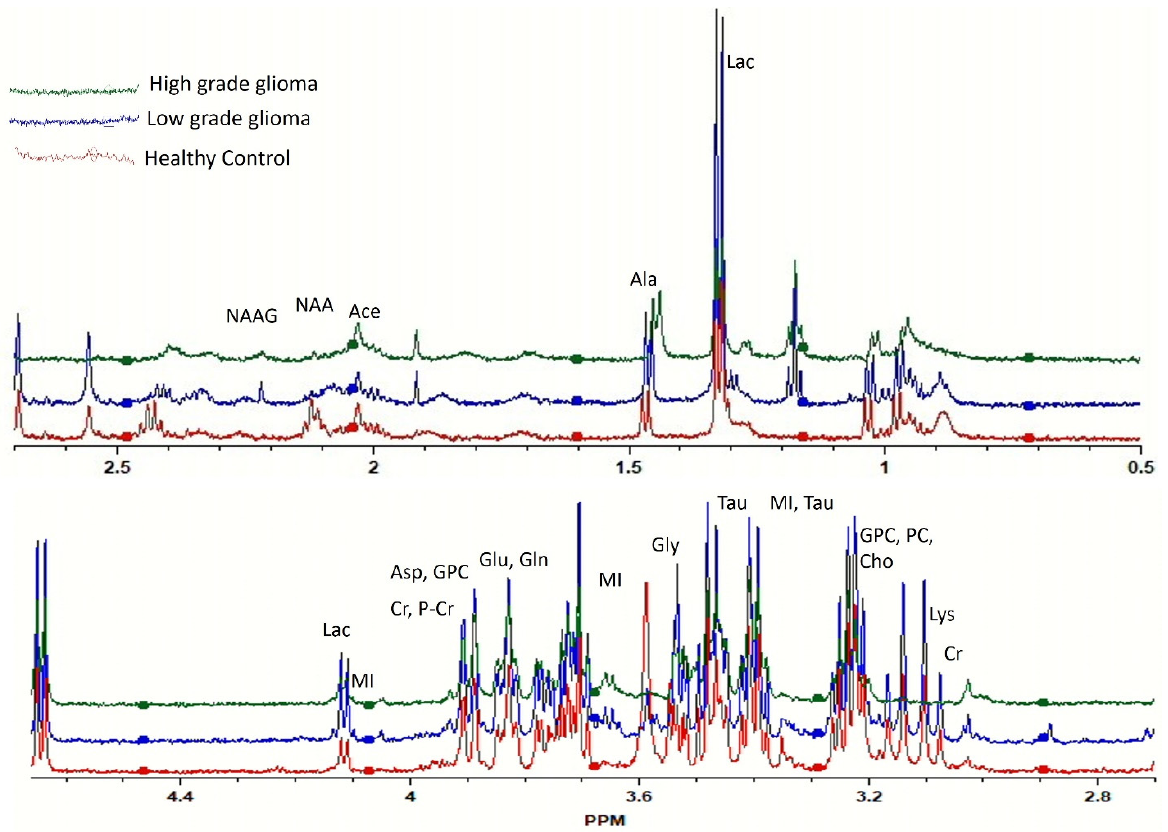
Figure 1. Comparison of high-resolution magic angle spinning nuclear magnetic resonance spectroscopy (HRMAS-MRS) spectra of healthy (red), low-grade glioma (LGG, blue), and high-grade glioma (HGG, green) study subjects. Important peaks are labelled.